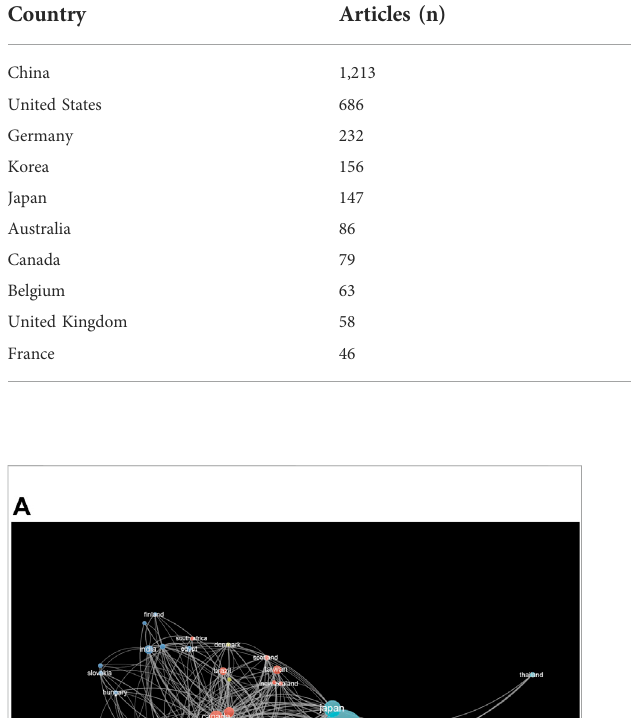
TABLE 2 The top 10 countries and institutions that have contributed to publications on necroptosis research.